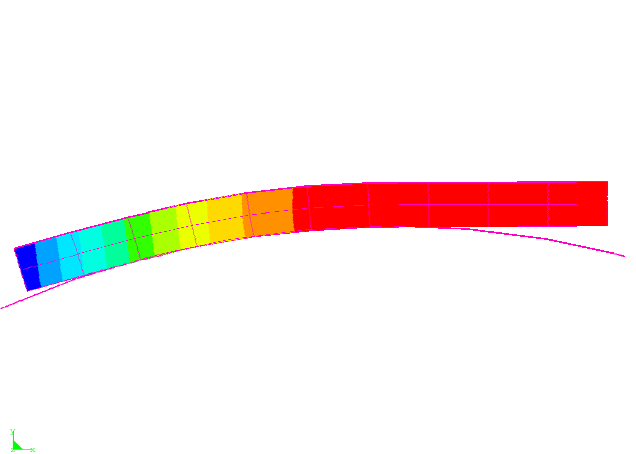
Fig. 13. Contact between a plate and a rigid cylinder: de- formed configuration.